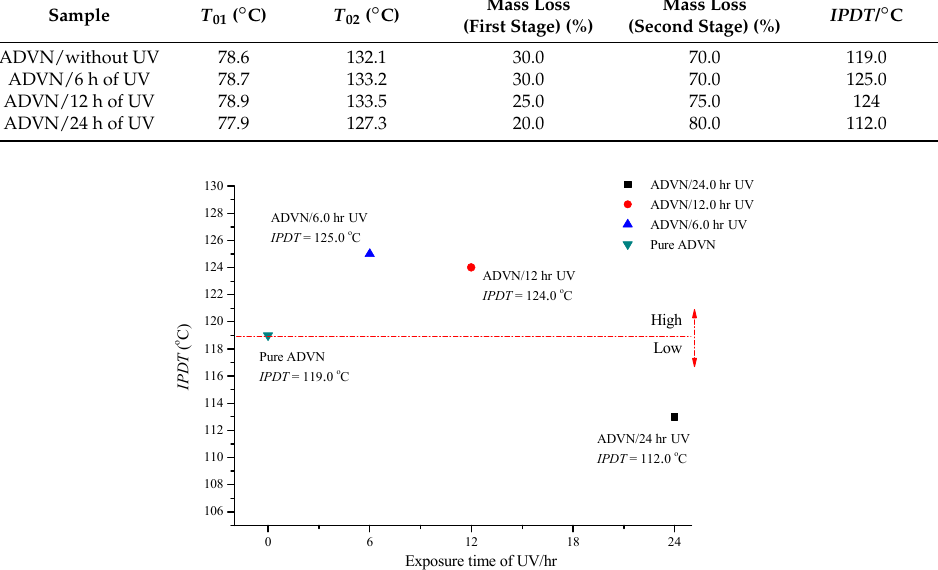
Figure 4. Calculation of IPDT for ADVN with different exposure durations of UV/6, 12, and 24 h by TG testing.